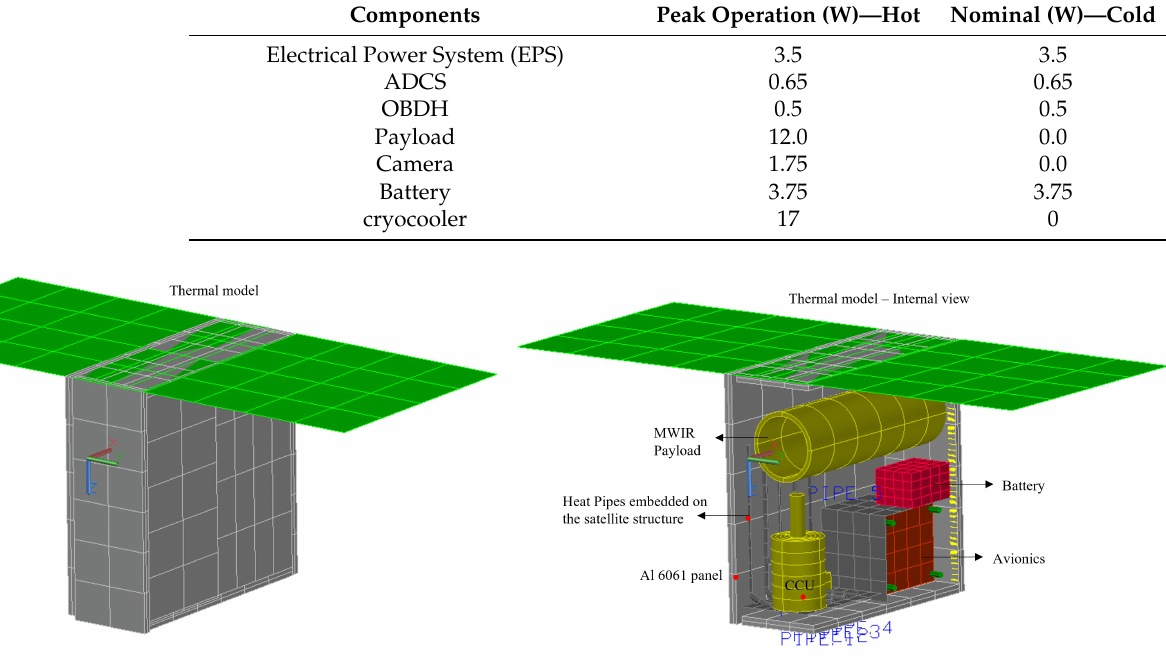
Figure 16. 6U Satellite Body-mount